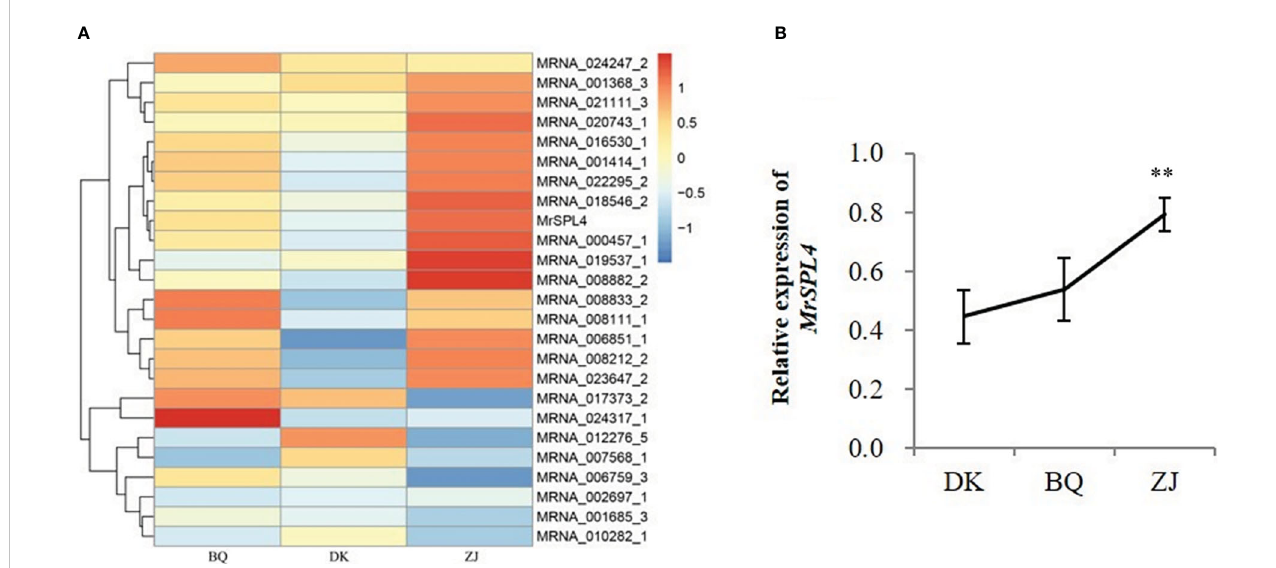
FIGURE 2 Expression of fl owering-related differential genes. (A) The expression heat map of fl owering related genes. (B) The relative expression of MrSPL4 in different samples. Values are the mean ( ± SD) of three replicates, ** indicates 0.001< p < 0.05 by the Student ’ s t-test.